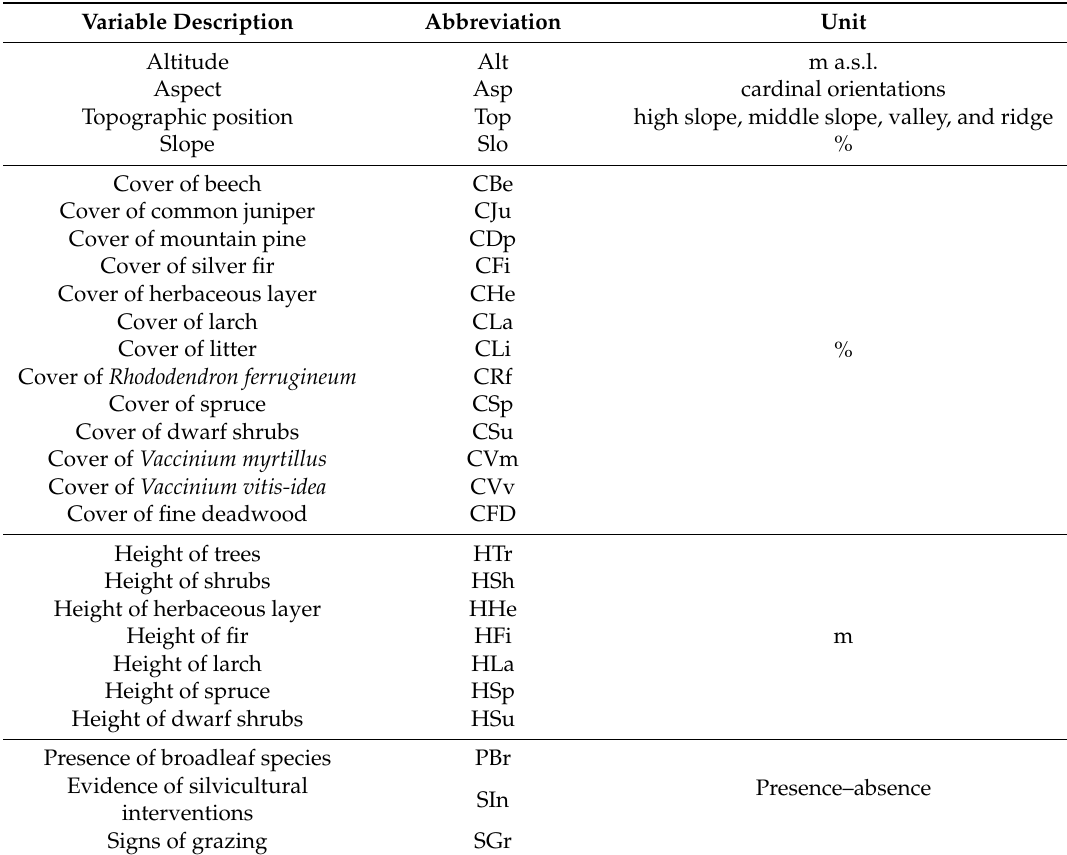
Table 2. Variables used to explain changes in capercaillie